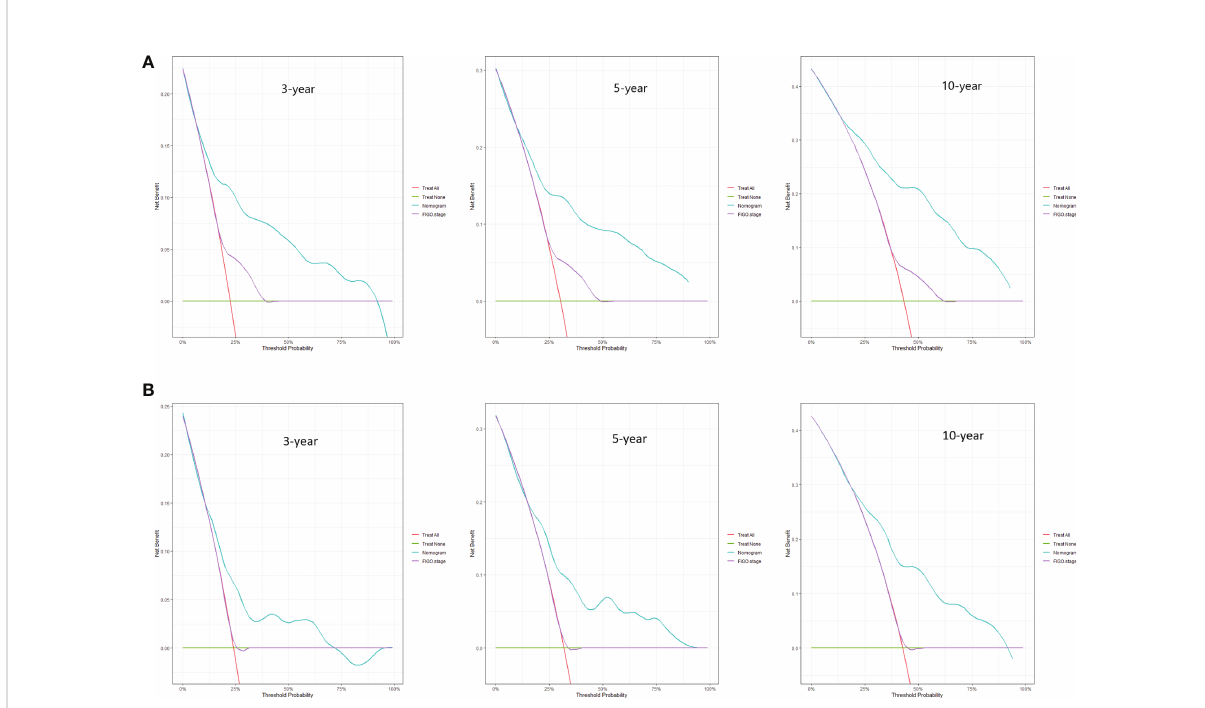
FIGURE 4 DCA curves for 3-, 5-, and 10-year OS among ECCC patients with FIGO stage I/II within the training cohort (A) and validation cohort (B) .